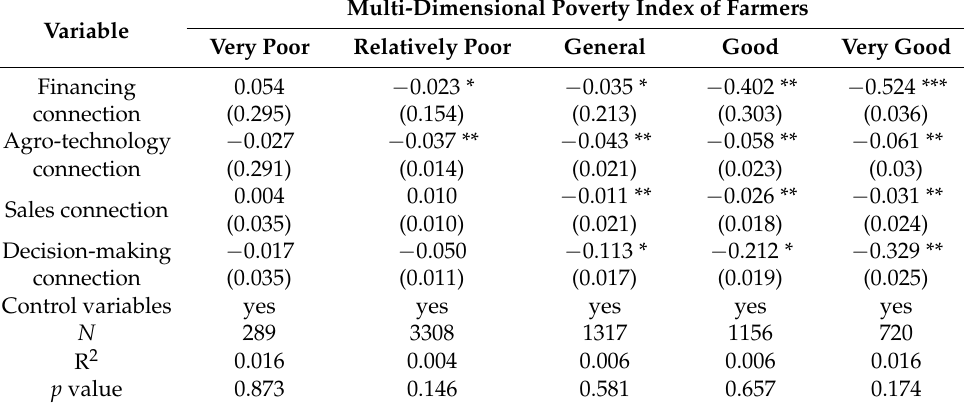
Table 7. Multidimensional poverty reduction effect of benefit coupling: heterogeneity of organiza- tional service